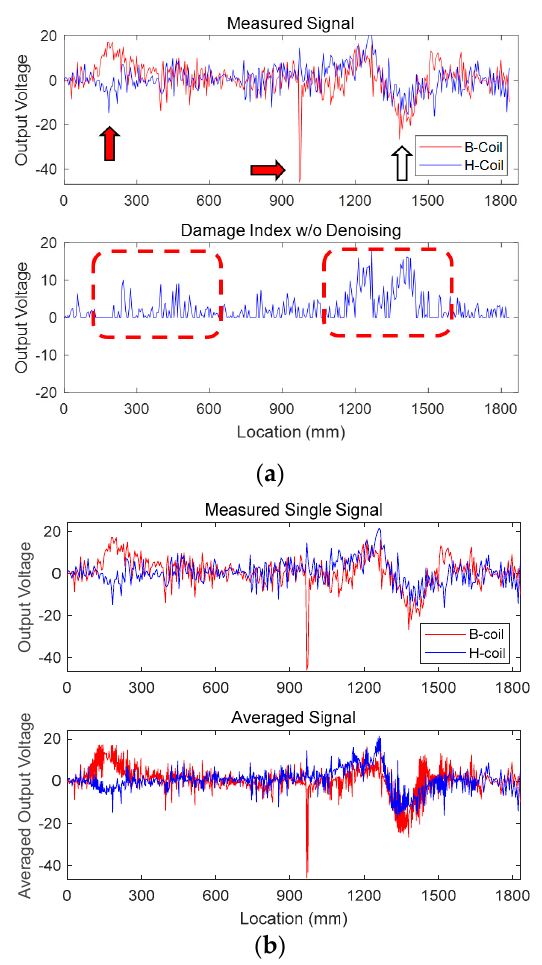
Figure4. SectionallossmonitoringusingnoisysignalsTSL2-1fromB-coilandH-coil: ( a )Measurednoisy Figure 4. Sectional loss monitoring using noisy signals TSL2-1 from B-coil and H-coil: ( a ) Measured signals ( top ) and damage index before denoising ( bottom ); ( b ) B-coil and H-coil signals after noisy signals (top) and damage index before denoising (bottom); ( b ) B-coil and H-coil signals after averaging.